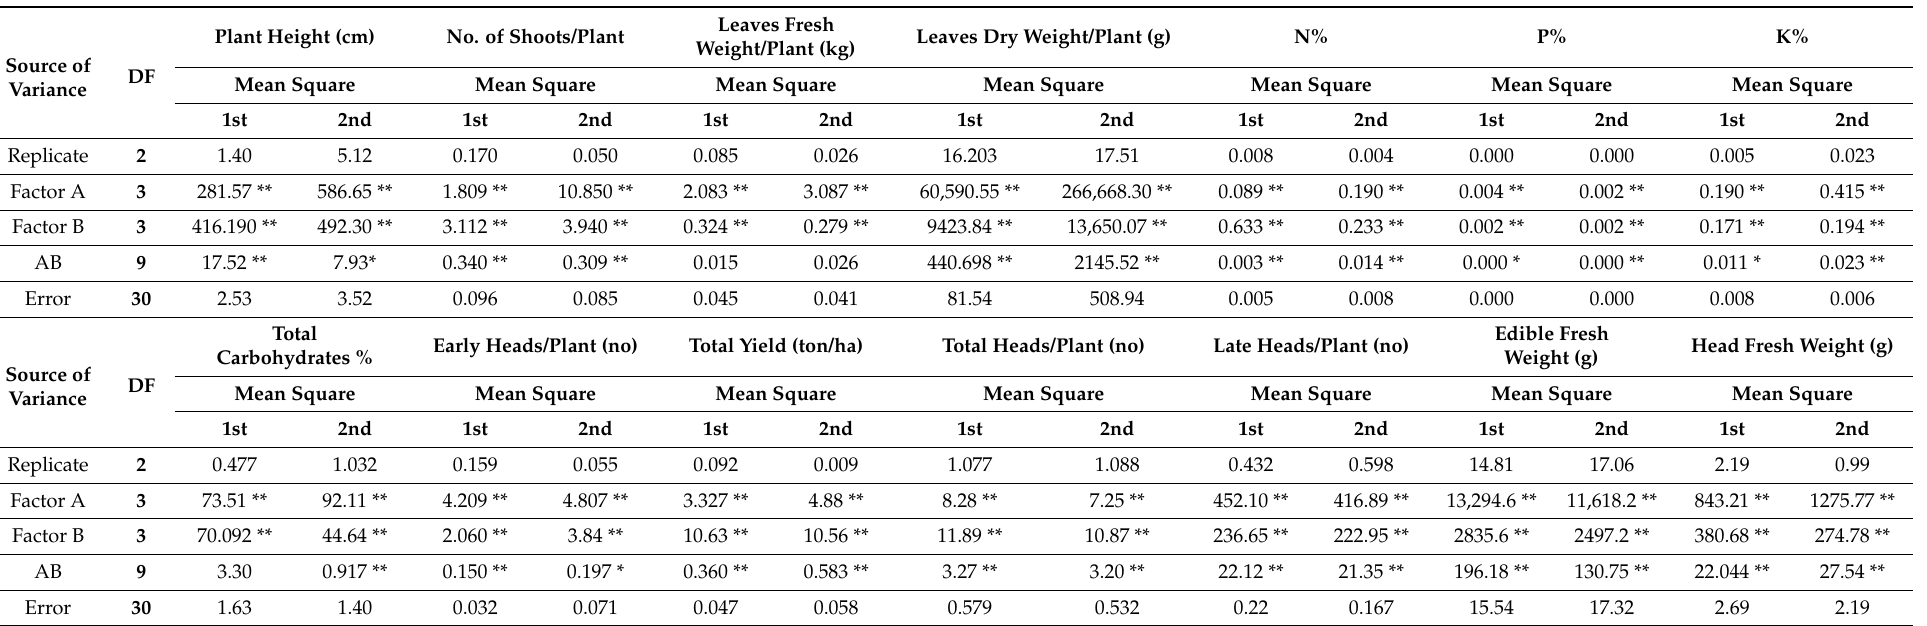
Table 2. The analysis of variance (ANOVA) for the effect of potassium sources (Factor A), seaweed extract application (Factor B), and their interaction (AB) on different parameters studied during the 2019 (1st) and 2020 (2nd)